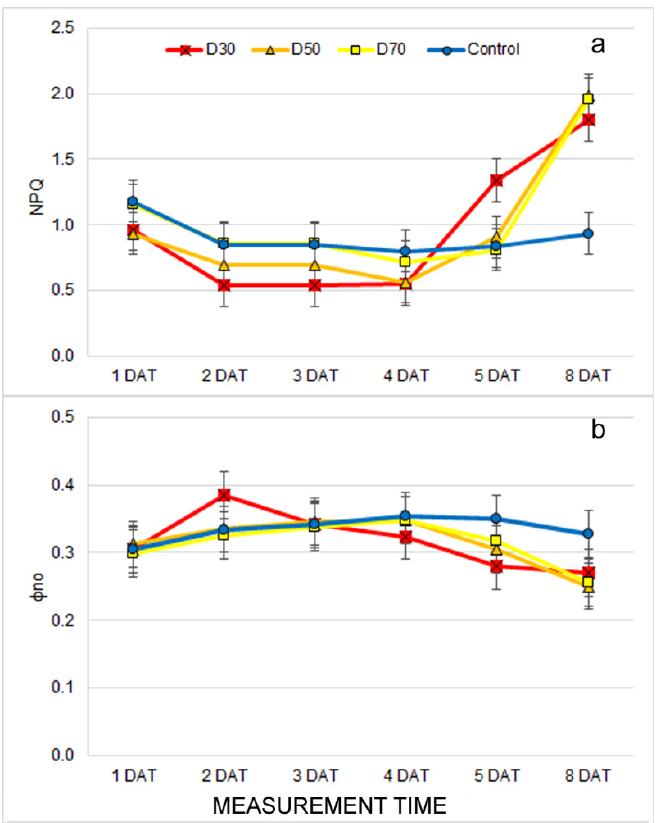
Figure 3. Mean ± double standard error (S.E.) for chlorophyll fluorescence traits: ( a ) non-photochemical quenching (NPQ), and ( b ) Quantum yield of non-regulated non-photochemical energy loss in PSII ( ɸ no) for plants grown under control and drought treatments (D30, D50, and D70) measured from the first to the eighth day after the beginning of treatments (1 DAT–8 DAT).